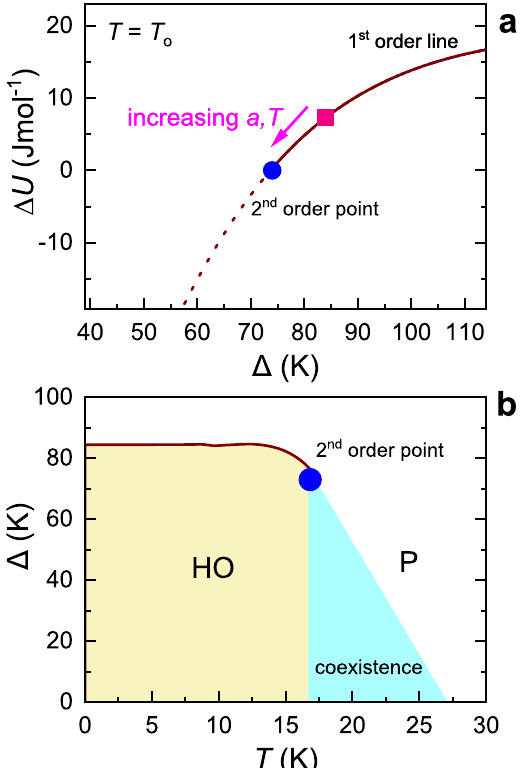
Fig. 8 Fits to the electronic speci fi c heat. a The measured Fig. 9 Vanishing latent heat. a Change in latent heat Δ U of the electronic speci fi c heat C exp ð T Þ of URu 2 Si 2 (data points from ref. 49 , phase transition between the paramagnetic and hidden-order after having subtracted γ HO ; see Methods) at different externally phases as a function of Δ according to Eq. (13), determined by applied values of the magnetic fi eld, as indicated. Alternating blue, setting F HO = F P . For large Δ , a fi nite latent heat causes the transition red, and olive lines (color scheme maintained in subsequent panels) to be of fi rst order (brown solid line). This is the case for the value of represent interpolations of C exp ð T Þ data points (black symbols), Δ = 84 K (solid pink square) obtained from an Arrhenius plot made while black lines indicate fi ts of C Δ given by Eq. (3) to C exp ð T Þ made for the regime T ≪ T o in Fig. 4. However, at a smaller value of Δ ≈ up to a temperature T max , beyond which an exponential form no 73 K, Δ U vanishes causing the transition to become of second order longer fi ts the data. To show the degree of departure, the fi tted lines ( fi lled blue circle). At smaller values of Δ , the free energies can no are extrapolated beyond T max . b A comparison of Δ values (pink longer be made to intersect at T = T o (dotted brown line). b A squares) obtained from fi ts of C Δ to C exp ð T Þ at different magnetic fi elds with Δ values (blue circles) obtained by setting Δ U = 0 in Eq. comparison of the temperature-dependent Δ ( T ) (brown line) σ (cid:6) μ estimated for B = 0 using Eq. (14) and the value of Δ (blue circle) (13). The black dashed line represents Δ ð B Þ ¼ Δ ð B ¼ 0 Þ (cid:2) ½ g (cid:5) B B , eff consistent with a second-order end point, identi fi ed by setting which is the expected behavior should Δ be reduced in a magnetic Δ U = 0 in Eq. (13). Yellow shading indicates where the hidden-order fi eld by Zeeman splitting with g (cid:5) ¼ 2.6 and Δ ( B = 0) = 84 K. The eff phase exists. Cyan shading illustrates schematically the possible inset shows n f values (open pink squares) obtained from fi ts of C Δ to region where phase coexistence due to inhomogeneities of C exp ð T Þ in ( a ). All error bars refer to the standard error of the mean. fl uctuations is